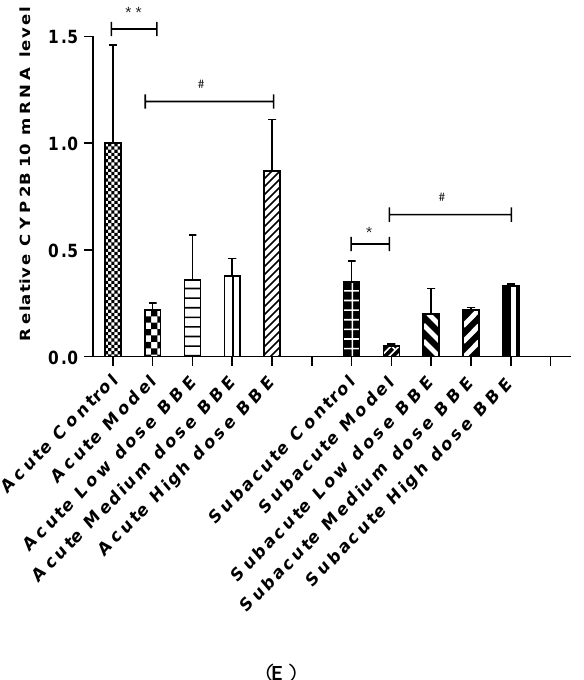
Figure 4. The qRT-PCR analysis of the PXR-Cytochrome P450s axis in ALD ( A – E ). Values are the mean ± standard deviation. Compared with control: *, p < 0.05; **, p < 0.01; ***, p < 0.001. Compared with model: # , p < 0.05; ## , p < 0.01; ### , p < 0.001.